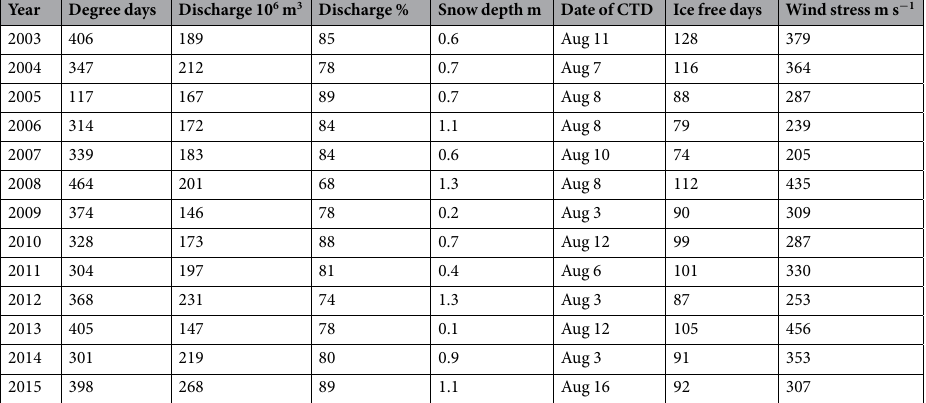
Table 2. Environmental data from the catchment area of Young Sound provided by the Greenland Ecosystem Monitoring Program. Positive degree days are calculated by summing average daily temperatures ( > 0) each year until the date of the hydrographic survey in the fjord. River discharge is the accumulated annual discharge by the Zackenberg River running into the fjord system. Discharge, % is the proportion of the annual discharge that takes place up until the date of the CTD sampling. Snow depth, is the maximum snow depth measured in the catchment area. Date of CTD gives the date of the sampling of hydrographic properties in the fjord. Ice free days, gives the duration of the sea ice free season in the outer part of Young Sound, corresponding to the 60–80 km part of the section in Fig 1b. Wind stress was estimated by summing daily average wind speeds during the ice free